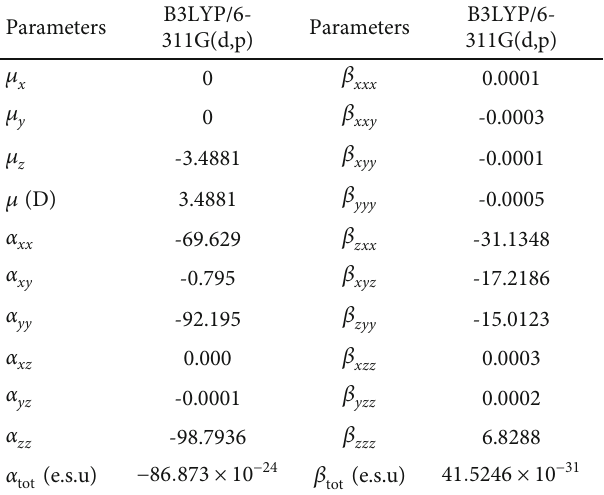
Table 4: HOMO – LUMO energy value and related properties of benzil calculated by B3LYP/6-311++G(d,p) method.